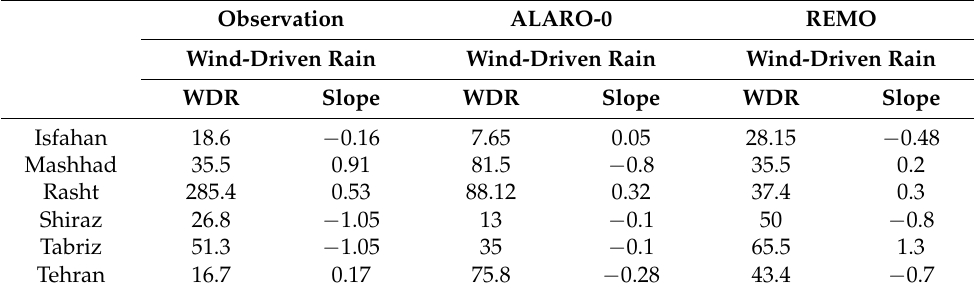
Table 6. Total annual wind-driven rain comparing models with observations over different loca- tions.WDR: annual WDR (mm/year); slope: trend slope (mm/year). Observation ALARO-0 REMO Wind-Driven Rain Wind-Driven Rain Wind-Driven Rain WDR Slope WDR Slope WDR Slope Isfahan 18.6 − 0.16 7.65 0.05 28.15 − 0.48 Mashhad 35.5 0.91 Rasht Shiraz Tabriz